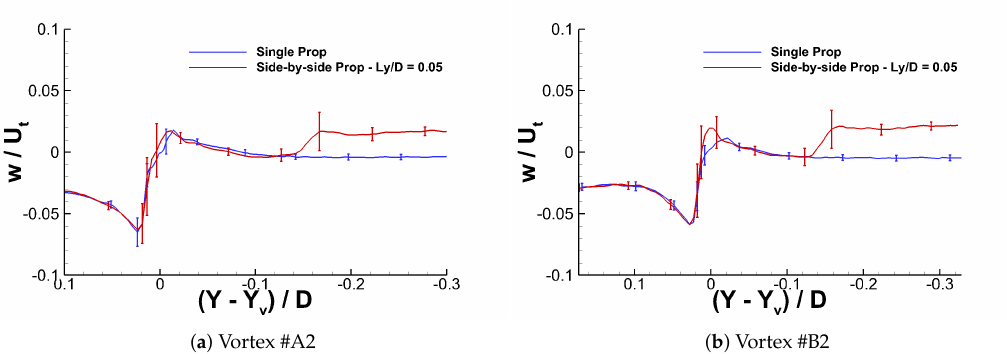
Figure 15. Comparison of the phase-averaged non-dimensional out-of-plane velocity component profiles w extracted in correspondence with the tip vortices core locations ( X v , Y v ) for blade azimuthal angle ψ = 90 ◦ for advance ratio J = 0.8 , Re D = 1.96 × 10 6 , and M t =